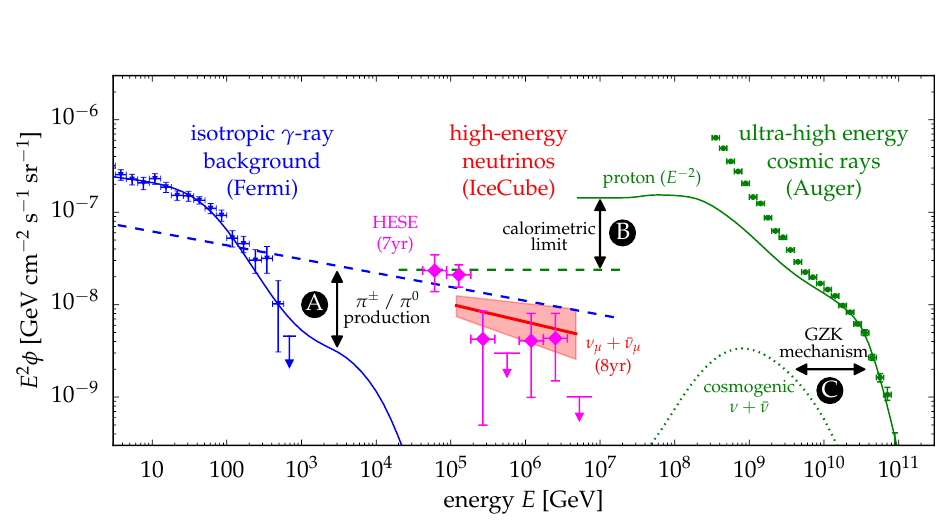
Figure 1. The spectral flux ( φ ) of neutrinos inferred from the eight-year upgoing track analysis (red fit) and preliminary results of the seven-year HESE analysis [8] (magenta data) compared to the flux of unresolved extragalactic γ -ray sources [10] (blue data) and ultra-high-energy cosmic rays [11] (green data). The ν µ + ¯ ν µ spectrum is indicated by the best-fit power-law (solid line) and 1 σ uncertainty range (shaded range). We highlight the various multimessenger relations: A: The joined production of charged pions ( π ± ) and neutral pions ( π 0 ) in cosmic-ray interactions leads to the emission of neutrinos (dashed blue) and γ -rays (solid blue), respectively. B: Cosmic ray emission models (solid green) of the most energetic cosmic rays imply a maximal flux (calorimetric limit) of neutrinos from the same sources (green dashed). C: The same cosmic ray model predicts the emission of cosmogenic neutrinos from the collision with cosmic background photons (GZK